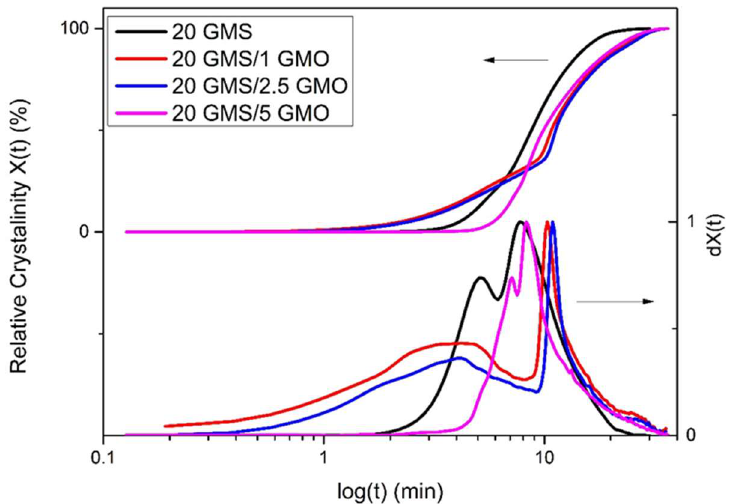
Figure 2. Relative crystallinity (X(t)) and first derivative of relative crystallinity (dX(t)) (quantified by DSC data) vs. time at cooling rate of 1 °C/min.